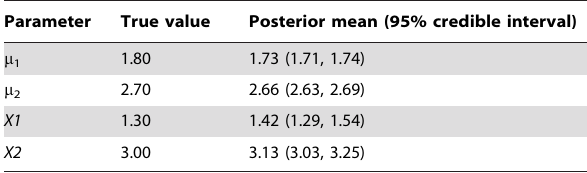
Table 2. Model results from simulation study for five different outbreak scenarios occurring during a 52 week simulated surveillance system.